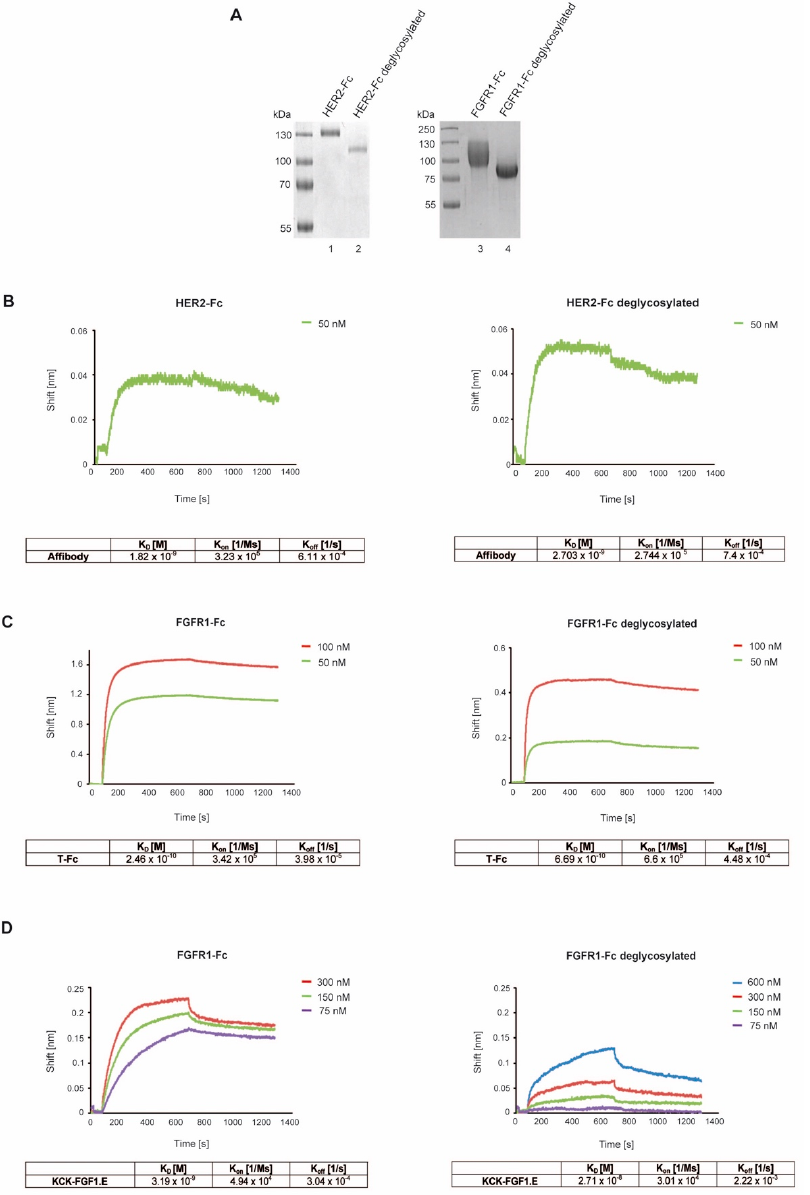
Figure 3. The significance of N-glycosylation for the interaction of CCs with RTKs. ( A ) SDS- PAGE analysis of enzymatic deglycosylation of HER2-Fc and FGFR1-Fc using PNGase F. ( B – D ) BLI-determined kinetic parameters of targeting protein interactions with FGFR1-Fc, HER2-Fc and their de-glycosylated variants. HER2-Fc or FGFR1-Fc and deglycosylated receptors were immobilized on BLI sensors and incubated with various concentrations of Affibody HER2 , T-Fc and KCK-FGF1.E. K D , k on and k off were calculated using ForteBio Data Analysis 11.0 software (Pall ForteBio, San Jose, CA, USA).